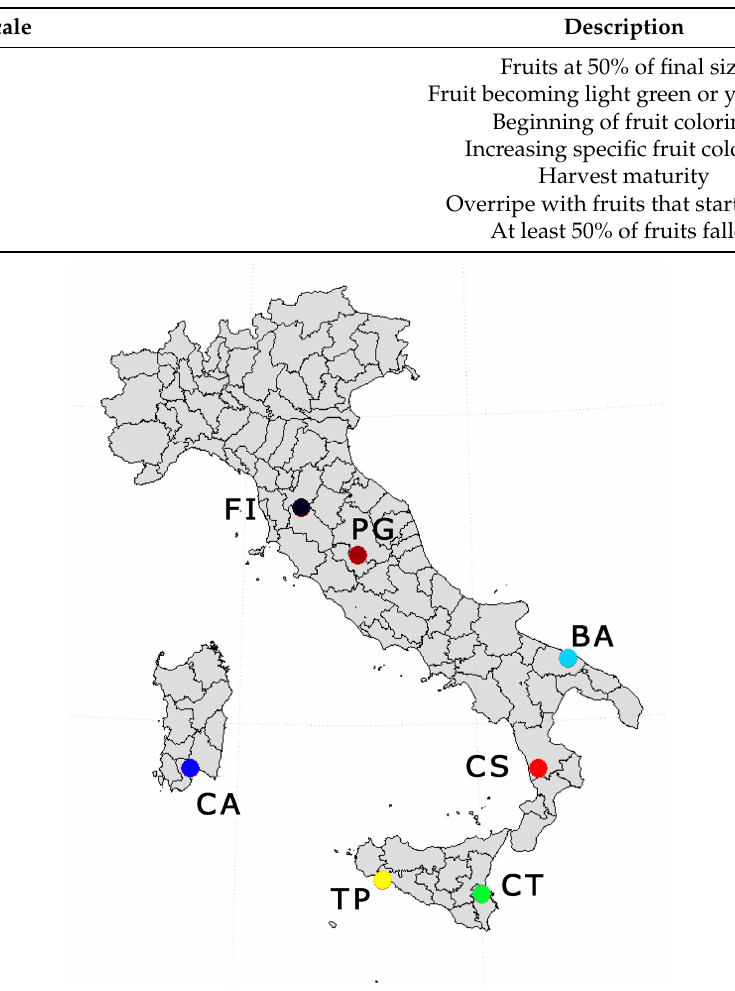
Figure 1. Geographical distribution of the experimental sites in the PHENAGRI project. The abbreviations indicate the provinces where the experimental fields were located .